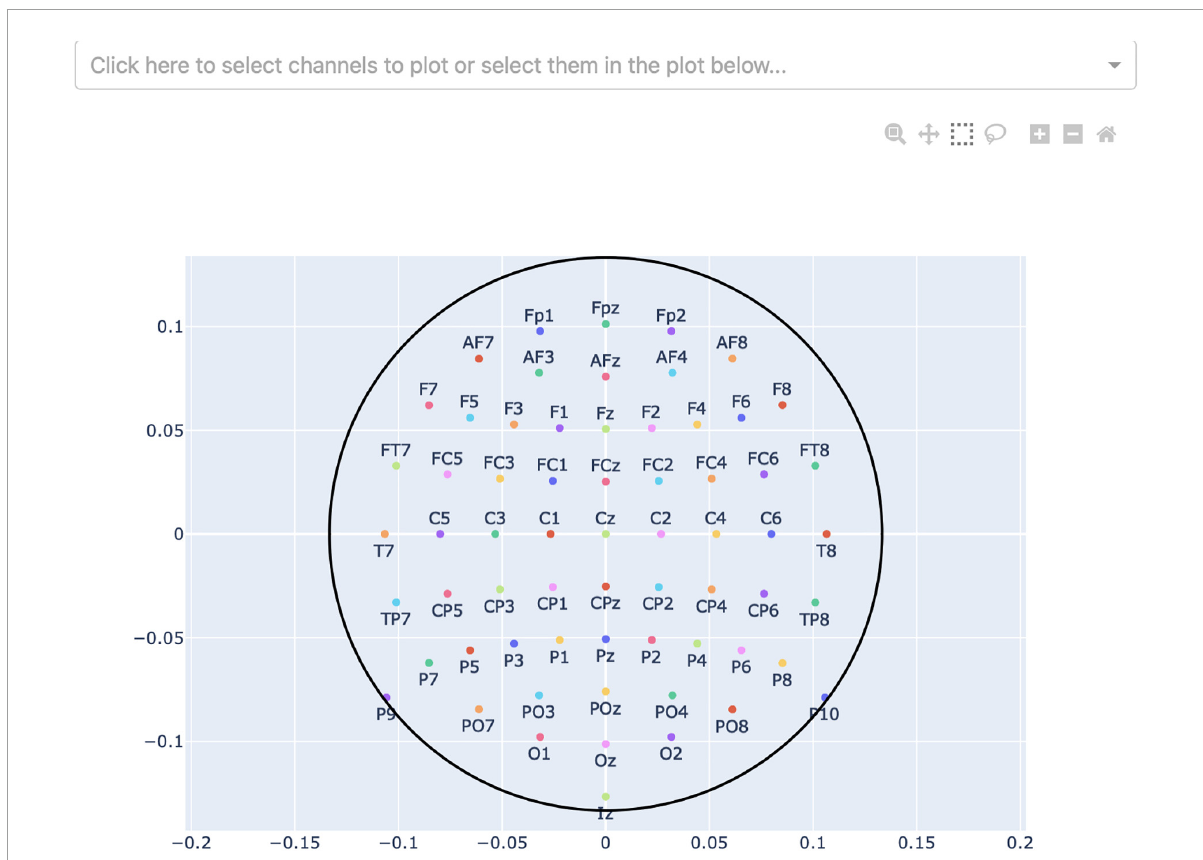
FIGURE5 Channel-selection pop-up window where the user can select specific channels to plot. At the top, there is a dropdown-menu to select channels out of a list of all channels. Alternatively, the channels can be selected on the channel layout below by clicking and dragging on the